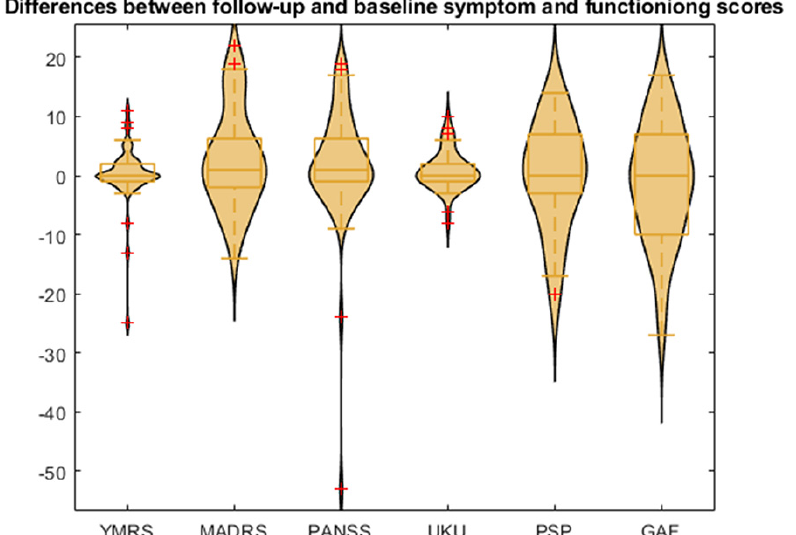
Figure 2. Distribution of the changes in symptom and functioning scores (follow-up score minus baseline status score). The yellow boxes are box-plot of the changes in scores, and the red crosses are outliers. YMRS: Young Mania Rating Scale; MADRS: Montgomery–Åsberg Depression Rating Scale; PANSS: Positive and Negative Syndrome Scale; UKU: UKU Side Effects Rating Scale; PSP: Personal and Social Performance Scale; GAF: Global Assessment of Functioning Scale. The red crosses represent the outliers in the distribution.